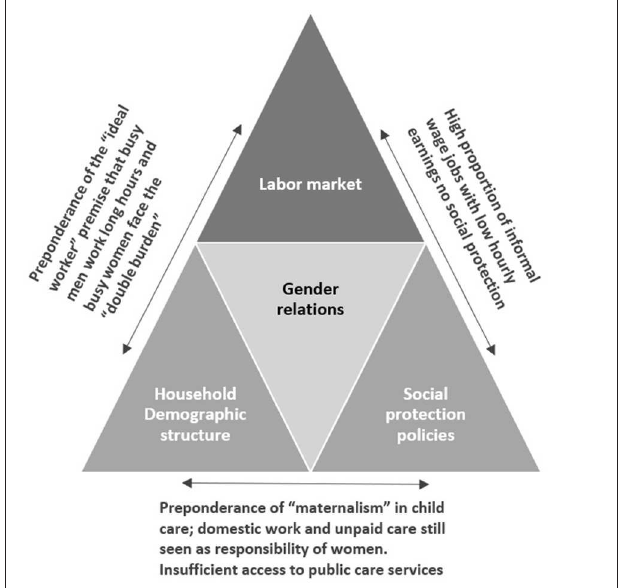
FIGURE 3 | The interconnected dimensions of deprivation, under the gender focus. Source: reprinted from Esquivel (2014).